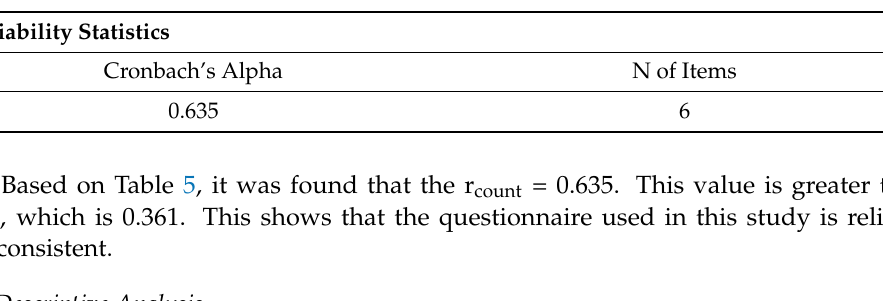
Table 5. Results of the Cronbach’s alpha value test.